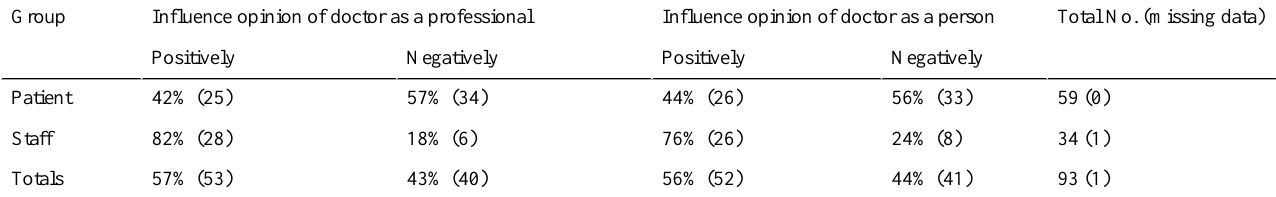
Table 3. Influence of opinion of doctor results, by